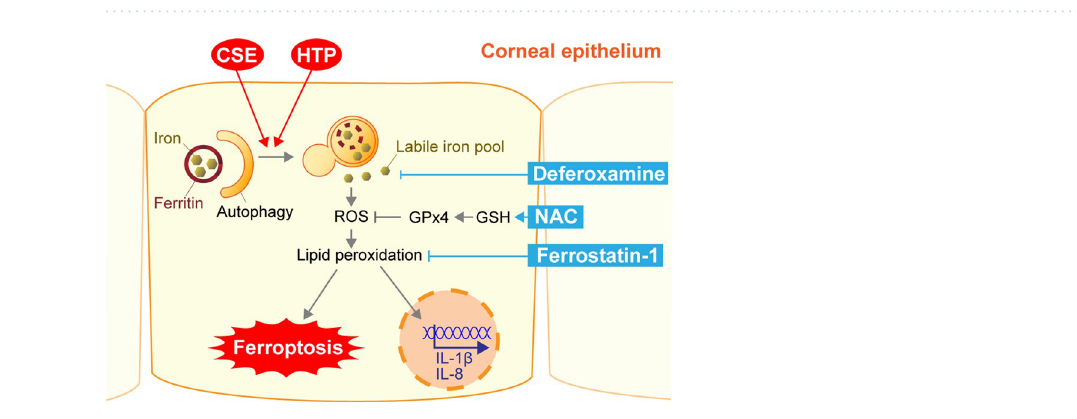
Figure 6. Neither cell death nor ferritin defect appeared in HCE-T cells treated with nicotine equivalent to 5% CSE. ( A ) Nicotine amount of CSE, HTP and NF-HTP used in the present study. ( B , C ) Results for cell death assay after exposure to nicotine (1, 10, 100, or 1,000 µg/mL) with or without 1 mM NAC. The quantification for the PI-positive cell ratios ( B ). Representative images of PI (magenta) and Hoechst 33342 (blue) staining ( C ). Bar = 100 µm. ( D , E ) Immunoblotting of extracts derived from HCE-T cells incubated without (control) or with either CSE (5%), or nicotine (10 µg/mL). ( E ) show the cleaved form of ferritin normalized to β-actin. Data represent the mean ± SEM (n = 6, ** P < 0.005, Student’s t -test vs. Control; ††† P < 0.001, Dunnett’s test vs. Control; ## P < 0.005, Student’s t -test vs. 5% CSE).